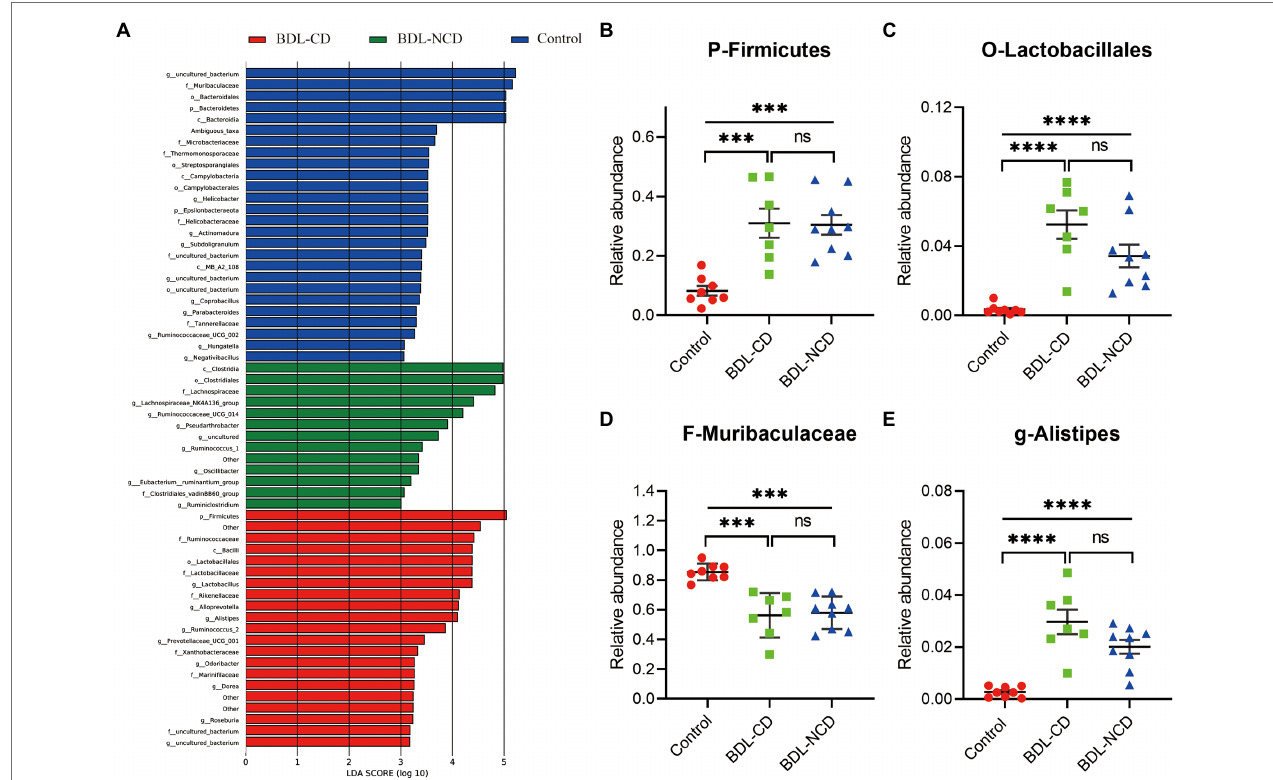
FIGURE 4 | Differentially abundant bacterial taxa between the control and BDL mice. (A) LEfSe analysis among the three groups. LefSe, Linear discriminant analysis Effect Size. (B) Relative abundance of the phylum Firmicutes . (C) Relative abundance of the order Lactobacillales . (D) Relative abundance of the family Muribaculaceae . (E) Relative abundance of the genus Alistipes . Data are presented as the mean ± SEM. *** p < 0.001; **** p < 0.0001; and ns, not